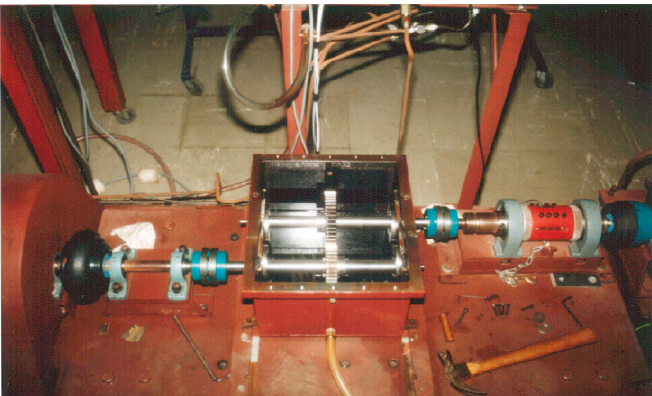
Figure 4. Schematic diagram of gearbox-fault experiment (Case II).